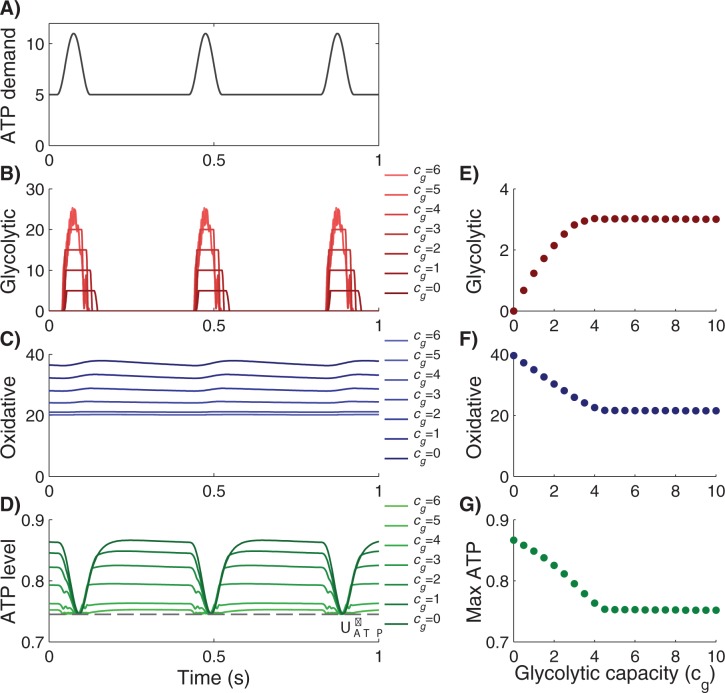
Typical dynamics of the system for different values of glycolytic capacity, cg.The optimal level of glycolytic capacity occurs where the curves in Panels E, F and G become flat. The left panels show the temporal dynamics of (A) ATP demand, d(t), (B) glycolytic ATP production, cgPg, (C) oxidative ATP production, copo, and (D) ATP level UATP. Dash line denotes the minimum ATP level that is allowed in the system, U*ATP. Higher glycolytic capacity allows more glycolytic ATP to supply peak demand and reduces the maximum ATP level that is needed to ensure that UATP≥U*ATP. The right panels show (E) total glycolytic ATP production over one period, Pgtotal, (F) total oxidative ATP production over one period, Pototal, and (G) maximum ATP level over the period max(UATP). Parameters used in this simulation: Demand parameters: f = 10Hz, period = 4, BL = 5, km = 50, kg = 10000, U*ATP = 0.745, Pgmax = 5 and cm = 1.